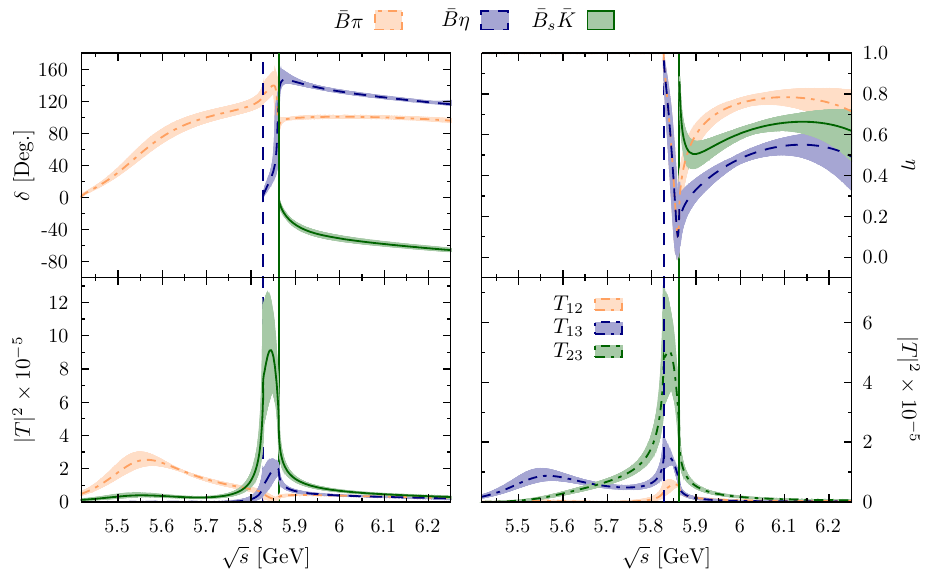
( 0 , 1 / 2 ) quark mass scaling rules discussed in the Appendix A. Error bands U have been obtained by Monte Carlo propagating the uncertainties of the LECs quoted in Ref.